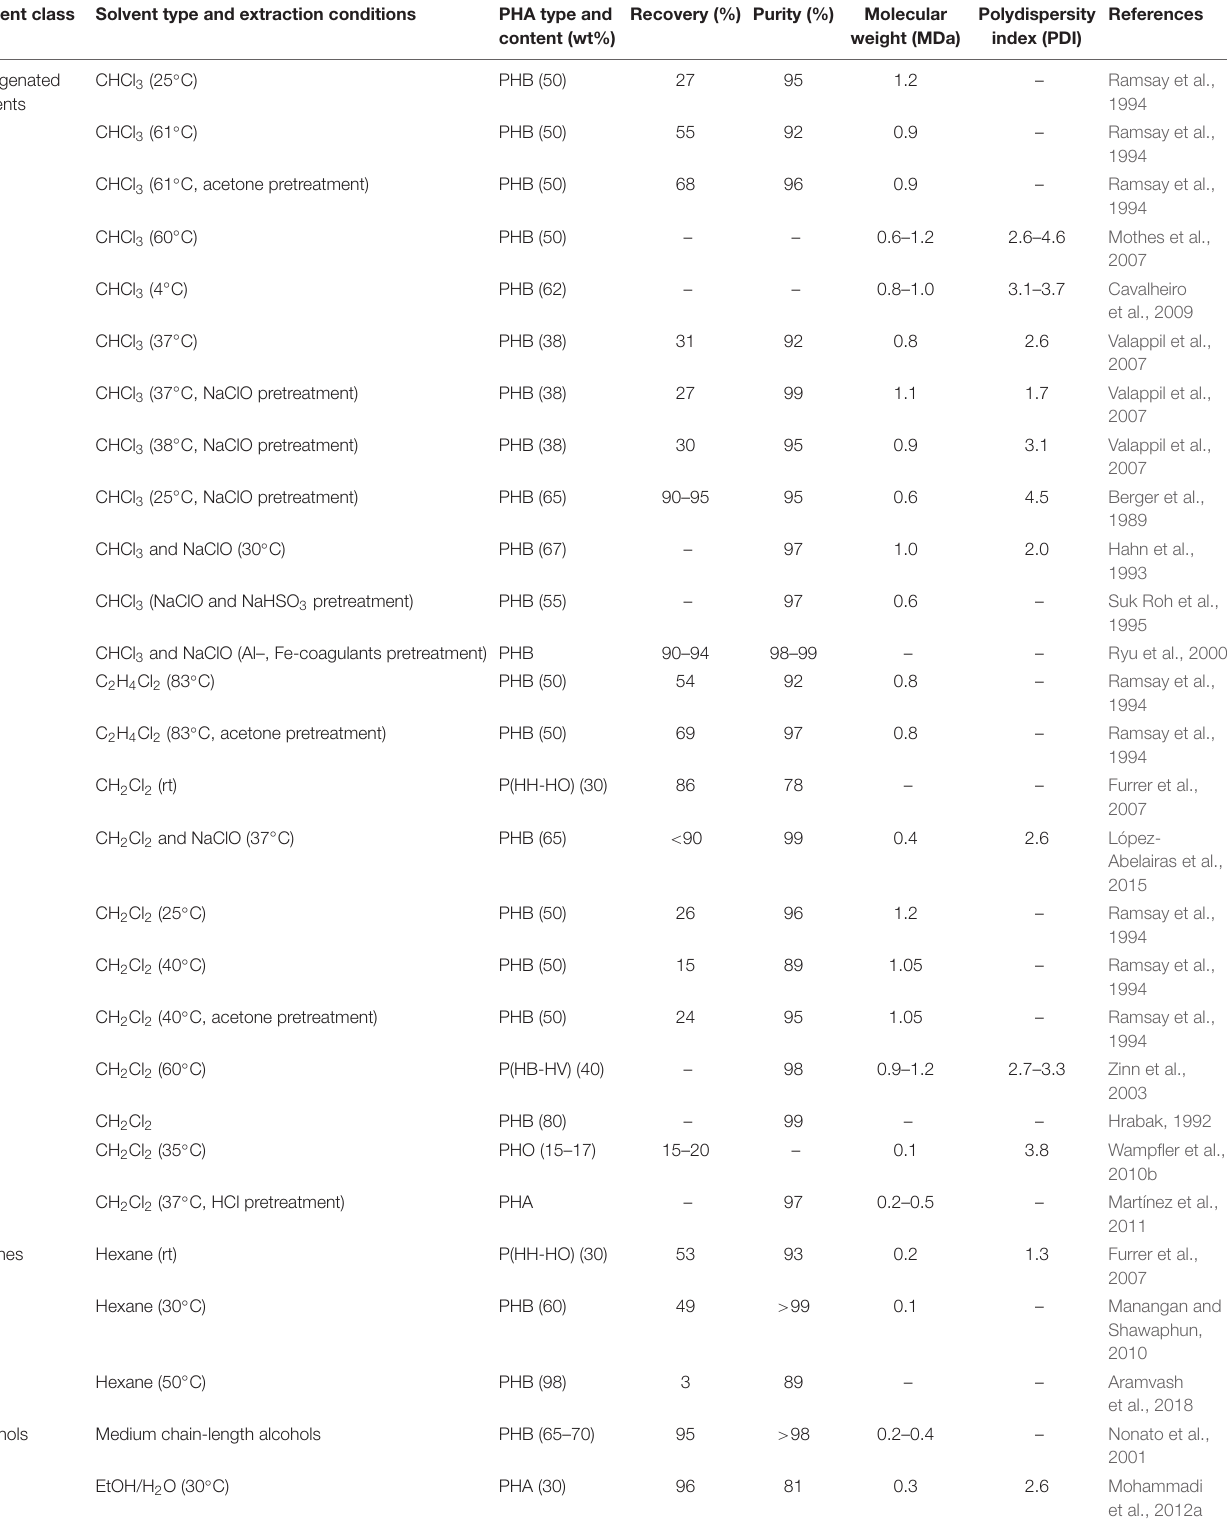
TABLE 1 | PHAs extraction from single strains with solvents. Solvent class Solvent type and extraction